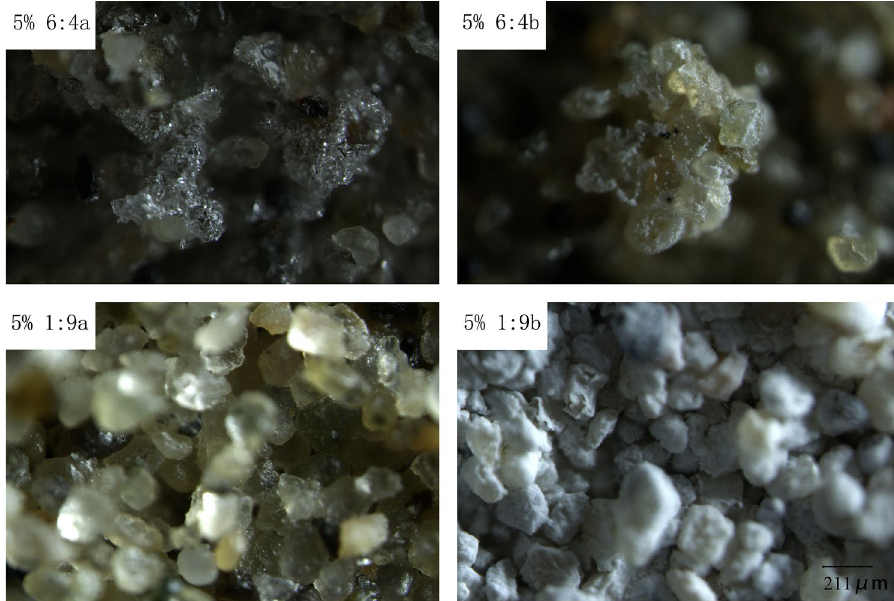
Figure 6. Comparison of microstructure images at different locations of the same sample surface. Salt-crust samples with a 5% mass percentage of salt and salt mixing ratios of 6:4 and